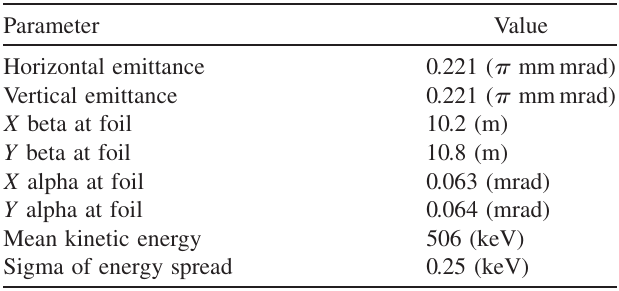
TABLE I. Parameters of the injected beam